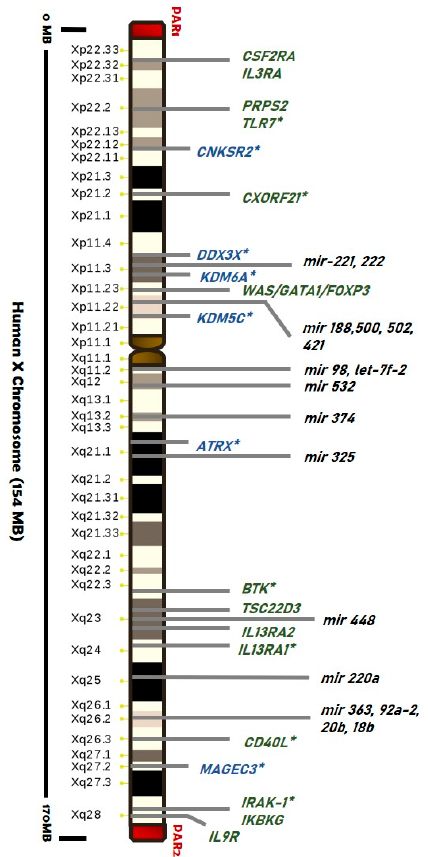
Figure 2. Map of the main genes and miRNAs (black) located on the human X chromosome associated with cancer development (blue) and autoimmunity (green). Genes that escape from the X-inactivation are labeled (*) (list of genes from [119,120]). Pseudoautosomal Region 1 and 2 (red blocks) and centromere (brown block) are